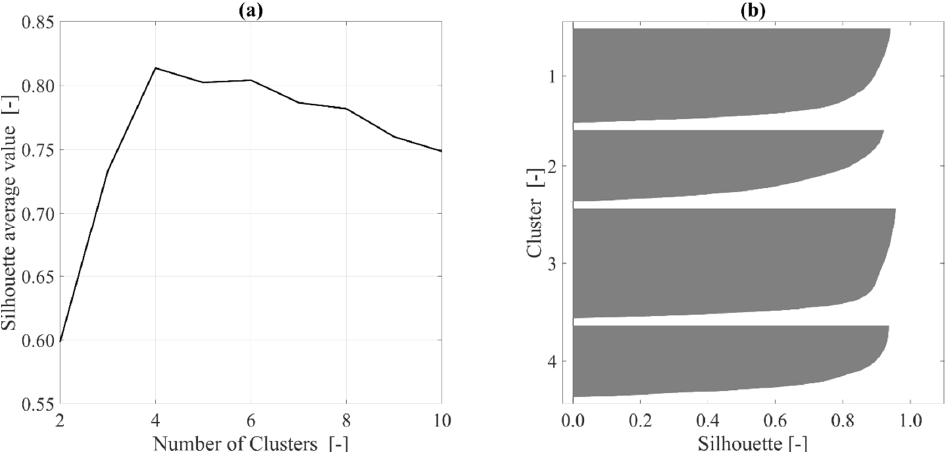
Figure 4. ( a ) Silhouette average value as a function of cluster number. ( b ) Data silhouette values for each cluster of the best cluster partitioning (four clusters). For both ( a ) and ( b ), the higher the values, the better the results.